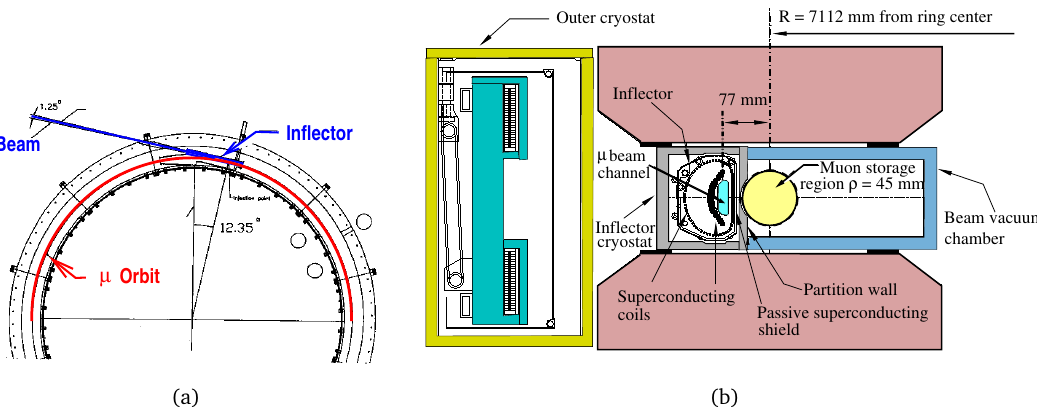
Figure 8: (a) A plan view of the incoming beam showing the location of the 1.7 m long superconducting inflector. (b) An elevation view of the inflector exit. The muon beam is into the page. The current in the “C” shaped arrangement of conductors flows in one direction, and in the opposite direction in the backward “D” shaped coil, producing a uniform vertical dipole field opposite to the main magnet field of 1.45 T, so that the beam enters the storage ring